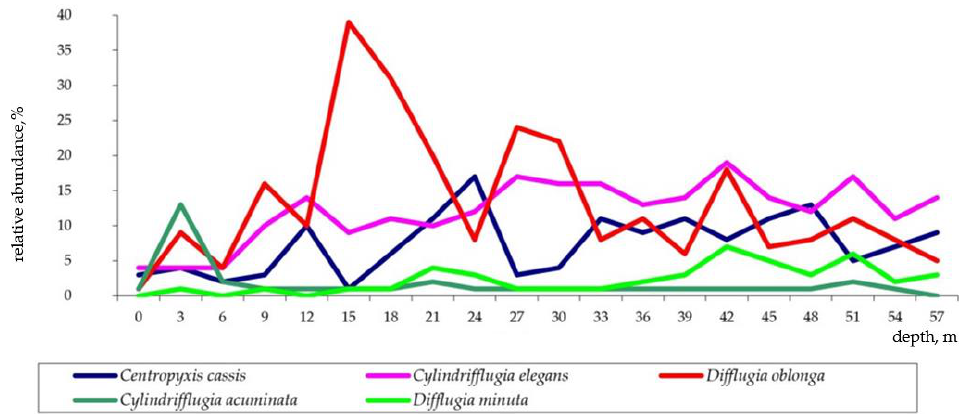
Figure 9. Relative abundance (%) of Centropyxis cassis , Cylingifflugia acuminata , C. elegans, Difflugia minuta, and D. oblonga . gia minuta, and D. oblonga